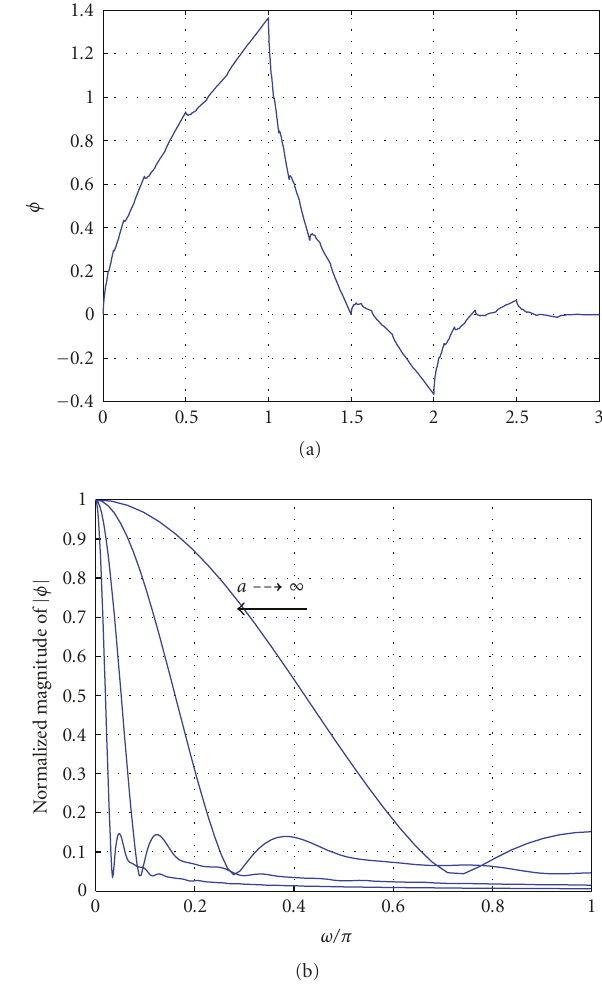
Figure 12: (a) db2 mother wavelet and (b) its Fourier transforms at various scales.